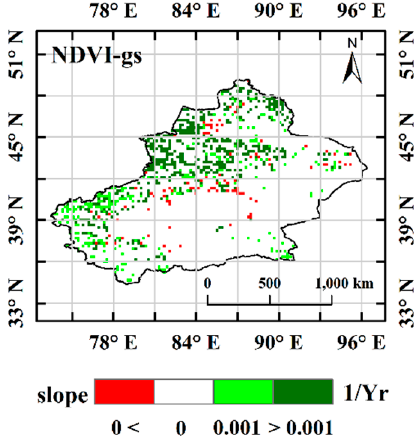
Figure 3. Spatial distribution of growing season NDVI trends from 1982 to 2011 over the Xinjiang region. Areas significant at the 95% level are presented.